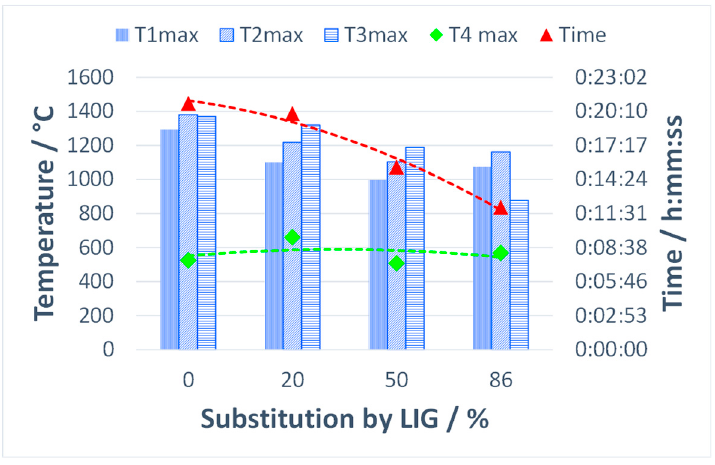
Figure 12. Impact of coke substitution with lignin on maximum temperatures and sintering time.